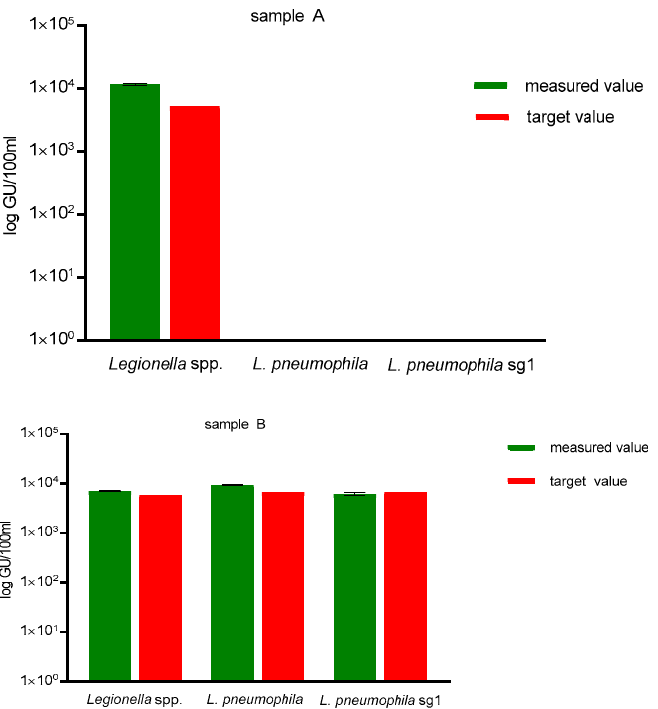
Figure 1. DNA extraction control for all qPCR assays. Measured values obtained for sample A (left graph), containing defined concentrations of 1.3 × 10 2 GU/100 mL L. bozemanii (sample A) showed no amplification for L. pneumophila and L. pneumophila sg 1, but correct amplification for Legionella spp. Measured values for sample B (right graph) showed correct amplification for all three assays, corresponding to the target values of 3.9 × 10 3 GU/100 mL L. pneumophila sg 1 for sample B.